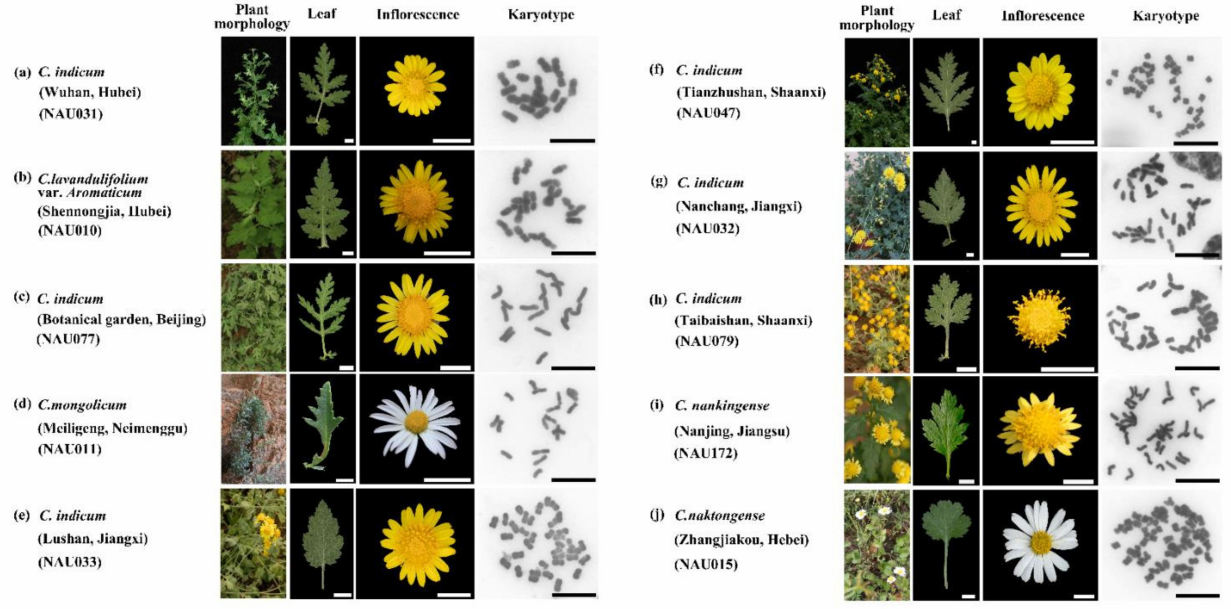
Figure 1. Identification of materials using cytogenetics (black bar = 10 µ m) and morphological analysis (white bar = 1 cm): ( a ) Chrysanthemum indicum (Wuhan, Hubei) (NAU031); ( b ) C. la- vandulifolium var. aromaticum (NAU010); ( c ) C. indicum (Botanical Garden, Beijing) (NAU077); ( d ) C. mongolicum (NAU011); ( e ) C. indicum (Lushan, Jiangxi) (NAU033); ( f ) C. indicum (Tianzhushan, Shaanxi) (NAU047); ( g ) C. indicum (Nanchang, Jiangxi) (NAU032); ( h ) C. indicum (Taibaishan, Shaanxi) (NAU079); ( i ) C. nankingense (NAU172); ( j ) C. naktongense